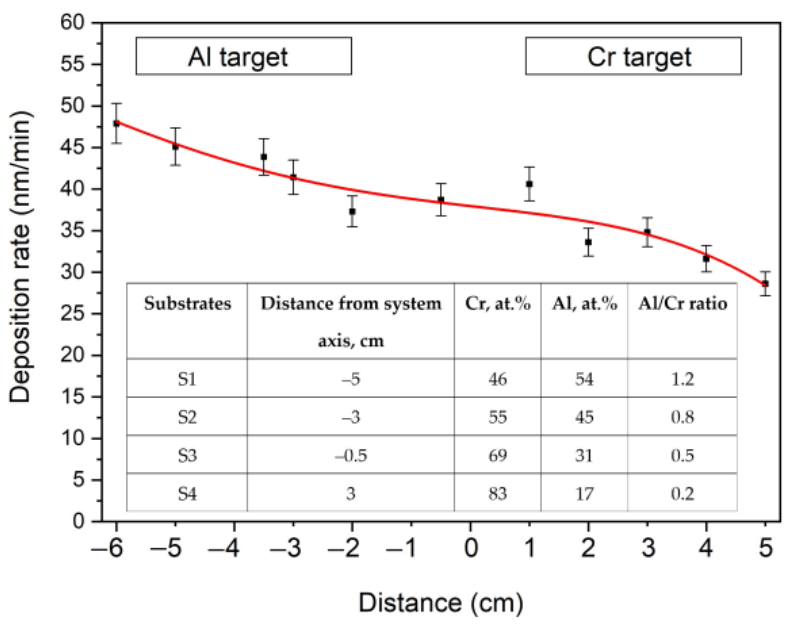
Figure 2. Lengthwise distribution of (Cr 1−x Al x )N coating deposition rate on substrate holder. Table: elemental composition of (Cr 1−x Al x )N coating.